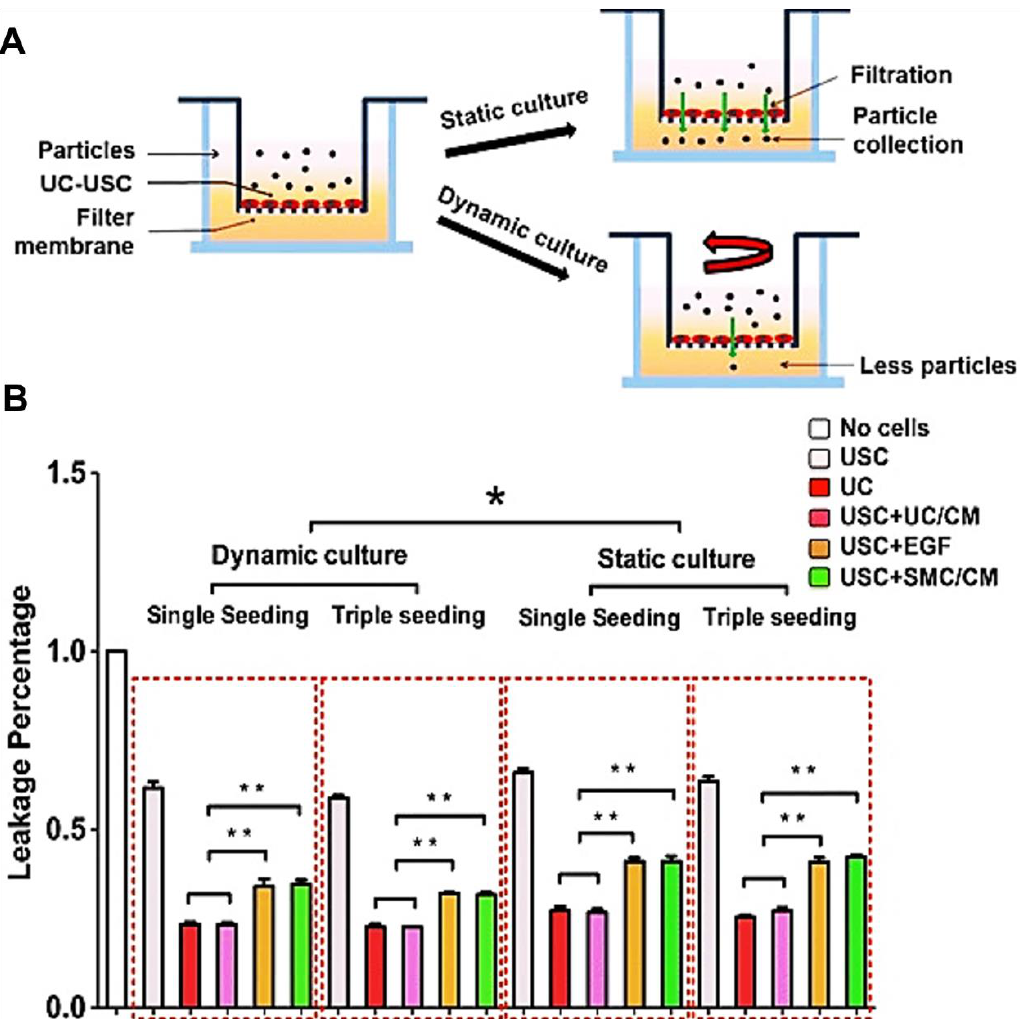
Figure 6. Permeability barrier function of urothelial induced USC. ( A ) Permeability test in vitro showed fewer leaking particles passed through urothelial induced USC formed barrier under dynamic culture, compared with static culture. ( B ) The qualification of leakage percentage indicated enhanced differentiation and barrier function of urothelial induced USC under UC/CM and dynamic culture, resembling physical urothelium. Abbreviations: USC, urine-derived stem cells; UC, urothelial cells; SMC, smooth muscle cells; CM, conditioned medium; UC/CM, urothelium-conditioned medium; SMC/CM, smooth muscle cell-conditioned medium; EGF, epidermal growth factor; single seeding, seeding cells only once; triple seeding, seeding cells each at first 3 days. * p < 0.05, ** p < 0.01. Images are adapted from Stem Cell Res Ther. [56] with permission. (License link: http://creativecommons.org/licenses/by/4.0/ accessed on 13 April 2022).